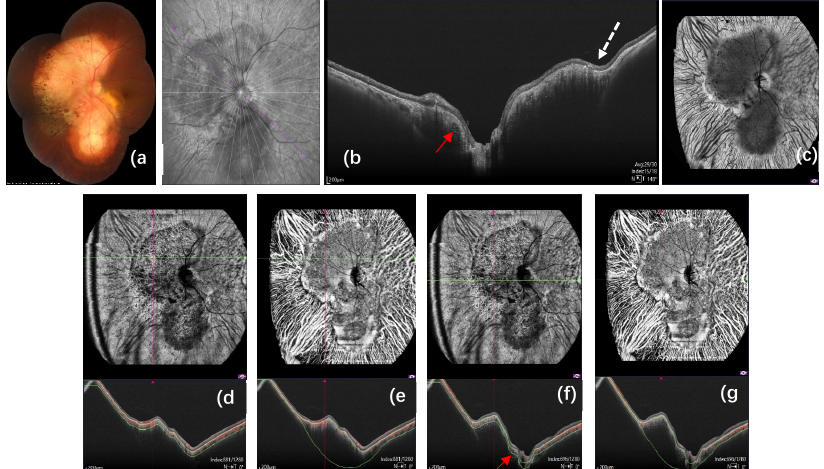
Figure 3. Multimodal imaging of patient 4 (see Table 1): ( a ) fundus photography shows a well-defined circumpapillary osteoma with macular involvement; ( b ) SS-OCT shows the unique CO features of horizontal lamellar lines, hyperreflective horizontal lines, horizontal tubular lamella, and vertical tubular lamella (red arrow) with obvious focal choroidal excavation (dashed white arrow); ( c ) an en face image corresponding to ( g ) shows the clear border of the entire osteoma; ( d , f ) an SS-OCTA image of the choriocapillaris layer shows the blood flow signal of the CO to be located mainly within the choriocapillaris and partly the Sattler’s layer on a composite B-scan. The hyporeflective tubular areas (red arrow), which were interpreted as intratumoral vessels, did not show a blood flow signal; ( e , g ) SS-OCTA segmentation covering the entire border of the osteoma on aligned B-scan images shows the tumor boundary clearly demarcated from adjacent vessels of the choroidal Sattler’s layer and Haller’s